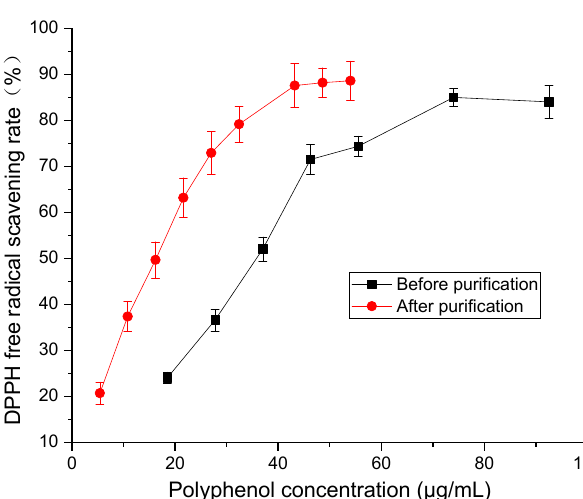
Figure 9. DPPH free radical scavenging rate of polyphenol from distiller’s grain before and after purification with D101 resin under the condition of 30 °C at 120 rpm for 24 h and eluted with 60% ethanol. Vertical bars represent the standard deviation for each value.